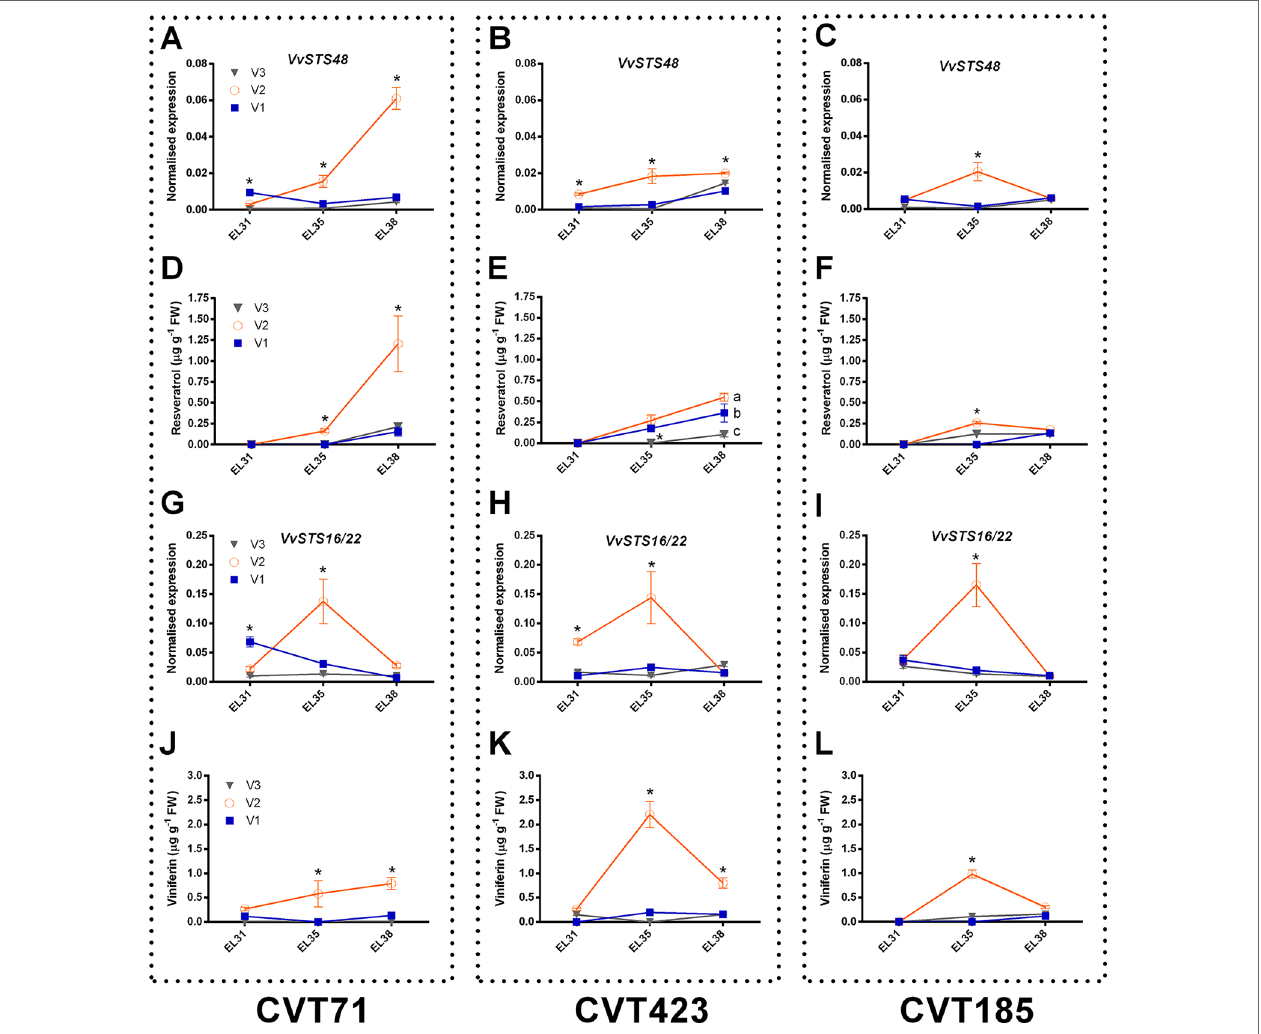
FIGURE 7 | Focus on stilbenoid metabolism. RT-qPCR expression profiles of genes encoding stilbene synthases (A - C) Vv STS48 (VIT_16s0100g01200) and (G - I) Vv STS16/22 (VIT_16s0100g00920) and accumulation patterns of stilbenoid compounds, resveratrol (D - F) , and viniferin (J - l) (both expressed as µg g -1 ), analyzed on whole berries collected in three vineyards (V1, V2, V3) from CVT71, CVT423 and CVT185 "Nebbiolo" clones at three ripening stages (E-L31, E-L35, E-L38) during the first year of trial (2013). Asterisk or lower case letters denote significant differences attested by Tukey’s HSD test ( P < 0.05 ) respectively when values were significant in only one or more samples. Bars represent standard error of the mean ( n = 3 ). The E-L31, E-L35, E-L38 stages from the modified E-L scheme respectively correspond to stage 75, 81, and 89 in the extended BBCH scheme.